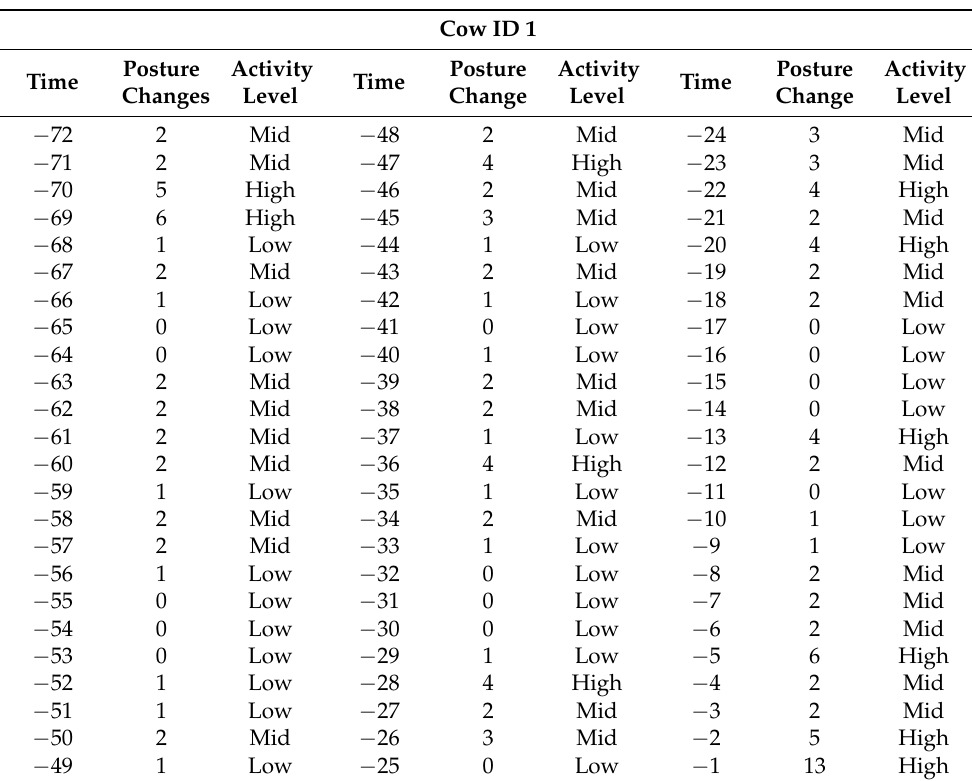
Table 3. Sample posture changes data in